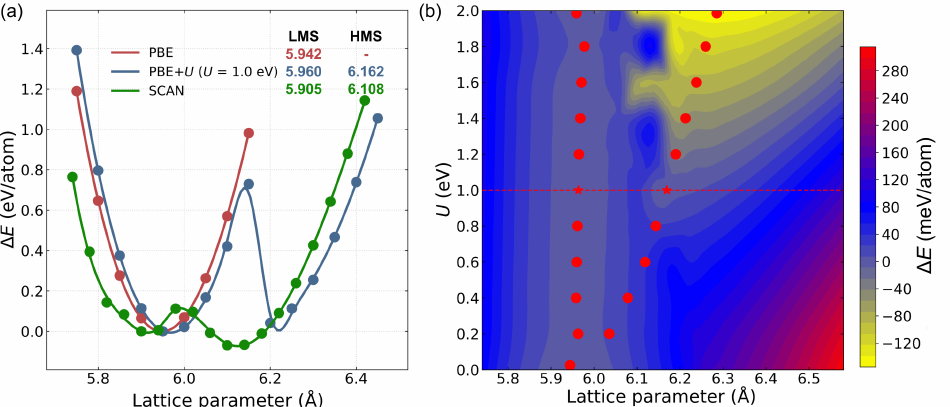
Figure 10. ( a ) The total energy difference ∆ E as a function of the lattice parameter of Mn 2 ScSi for the PBE, SCAN, and GGA + U ( U = 1 eV) solutions. ( b ) The ∆ E for Mn 2 ScSi calculated by GGA + U for a set of U values and mapped into the diagram “Coulomb repulsion term ( U ) – lattice parameter ( a )”. The optimized lattice parameters for both LMS and HMS are marked by the red symbols. The stars denote the degeneracy of the ground state, for which the LMS and HMS have similar energy values at U = 1 eV. For each case, the ∆ E is plotted with respect to the left energy minimum